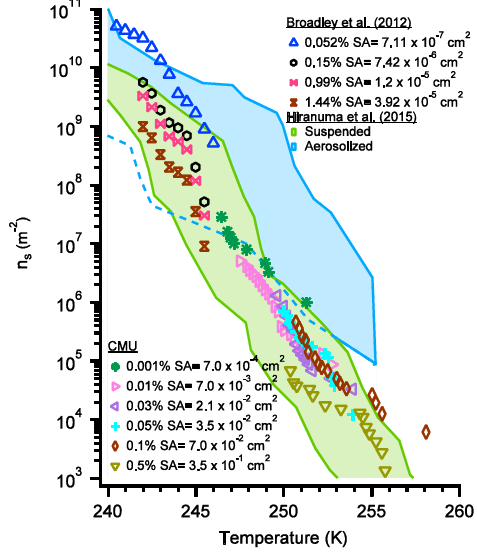
Figure 11. Range of n s values for illite NX mineral dust compiled from 17 measurement methods used by different research groups, the details of which are described by Hiranuma et al. (2015a). The range of data is summarized into shaded sections to separate sus- pended droplet techniques (such as the cold plate) from techniques where the material under investigation is aerosolized before immer- sion freezing analysis. Data from both the Broadley et al. (2012) and the CMU cold plate systems are also plotted to show how much of the range can be spanned via the critical area effect (blue trian- gles) and the concentration saturation effect (purple hexagons and red and brown bow